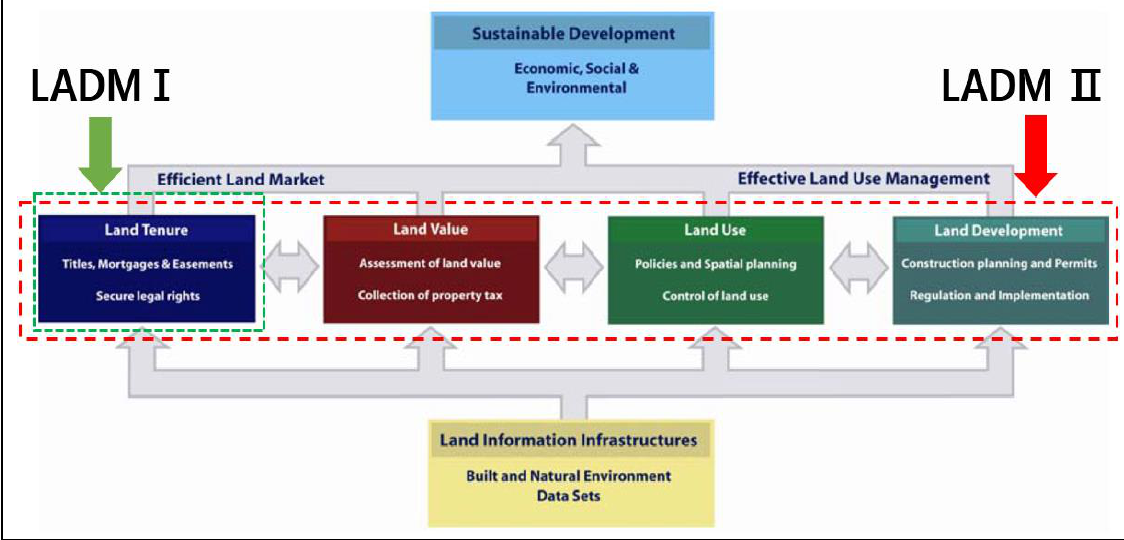
Figure 1. Land administration functions considering the scope of LADM I and II. Adapted from [3,6].